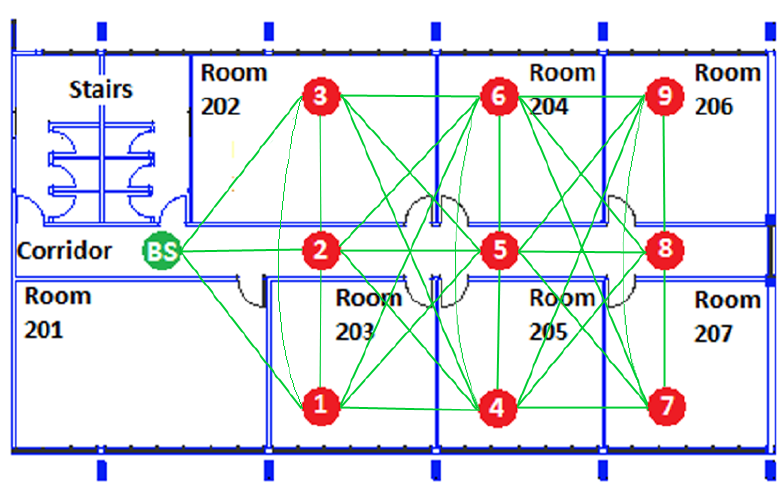
Figure 2. Testbed topology and connectivity map.